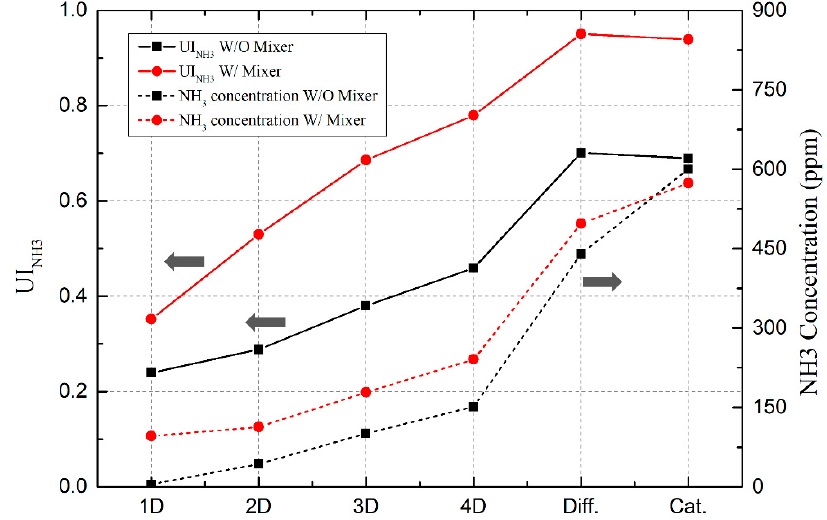
Figure 8. UI and concentration of NH 3 at specific locations with and without mixer.